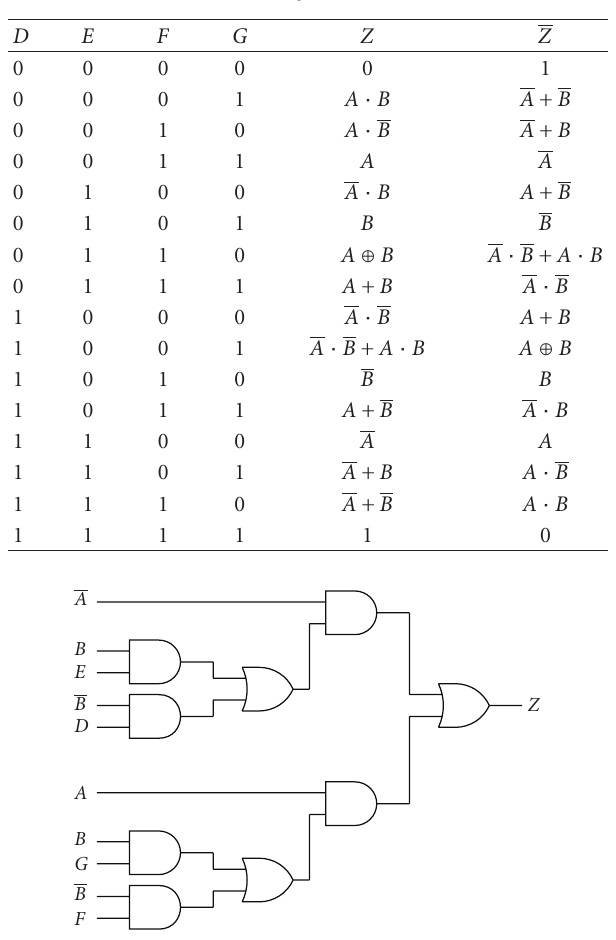
Table 1: The PQ-cell LU functions.